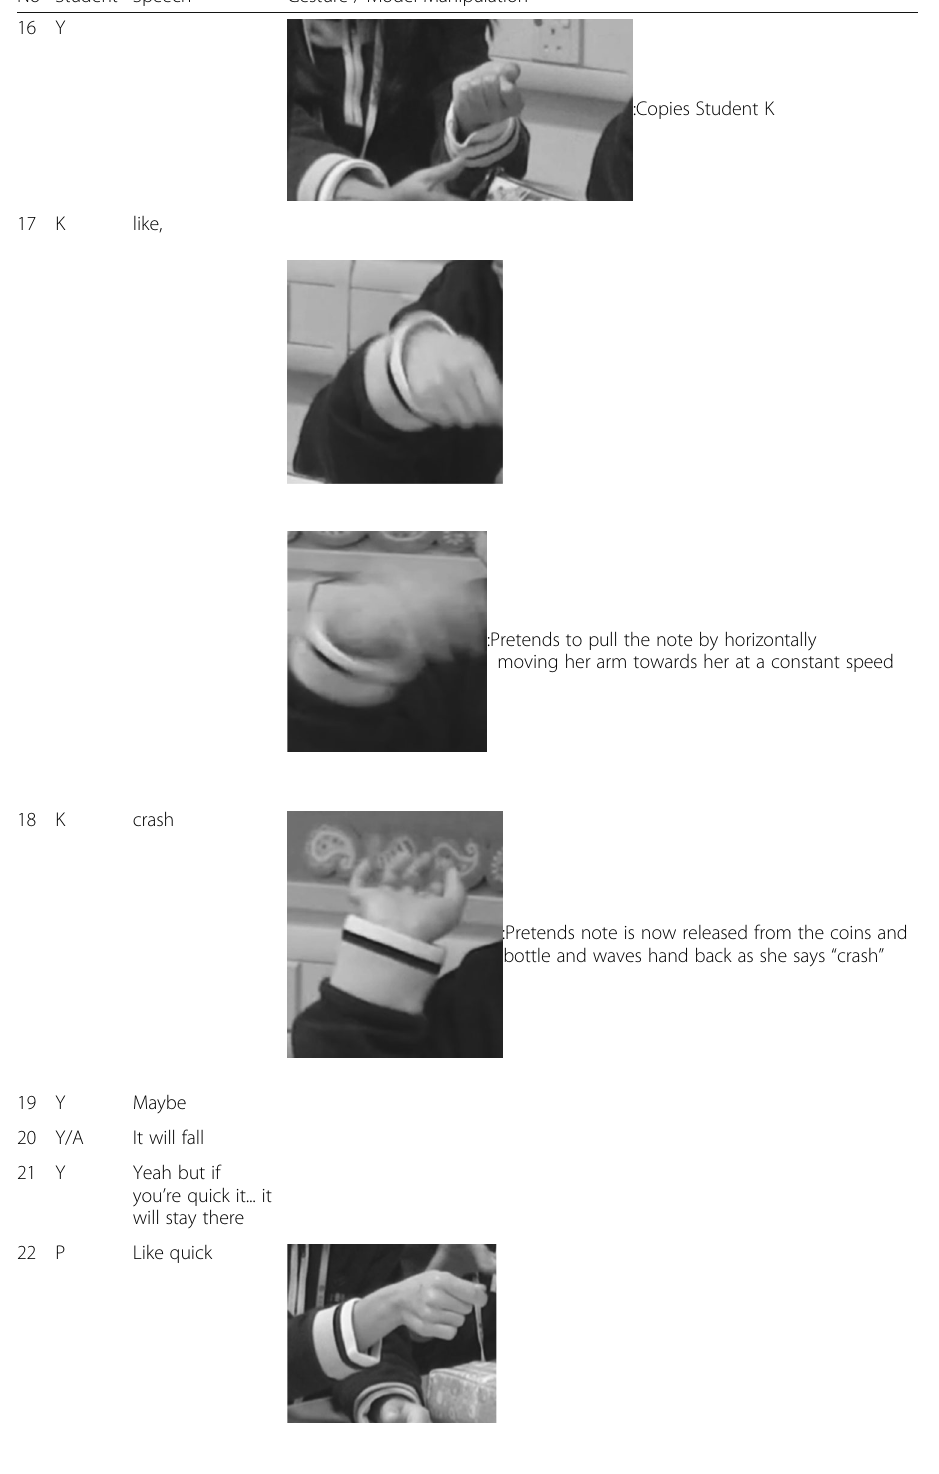
Table 1 Identification of Science Concepts in Group 2